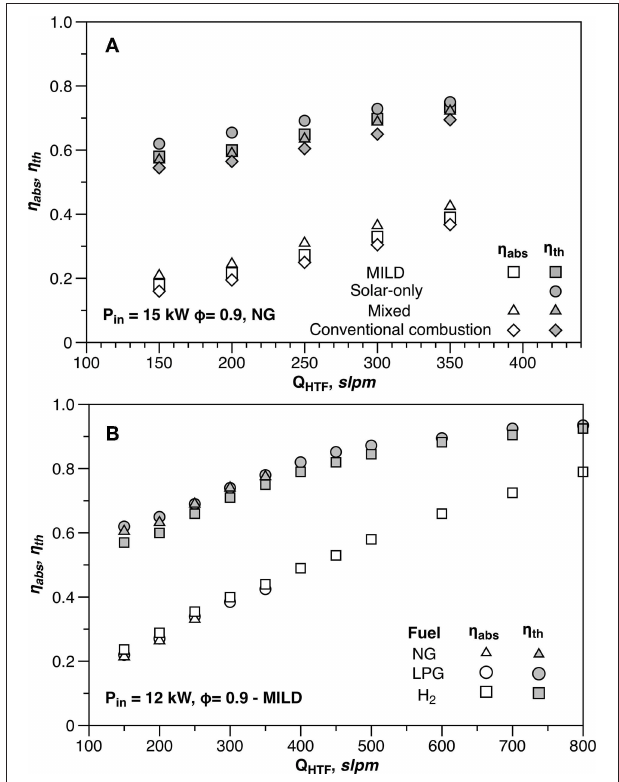
FIGURE 7 | Measured NOx emissions for the MILD (A,B) and mixed (B) modes of operation, as a function of the fuel type, and for a fixed HTF flow rate (150 slpm), thermal input ( P in = 12 kW) and equivalence ratio ( φ = 0.9). Data from Chinnici et al. (2018a,b); Chinnici et al. (2019a).